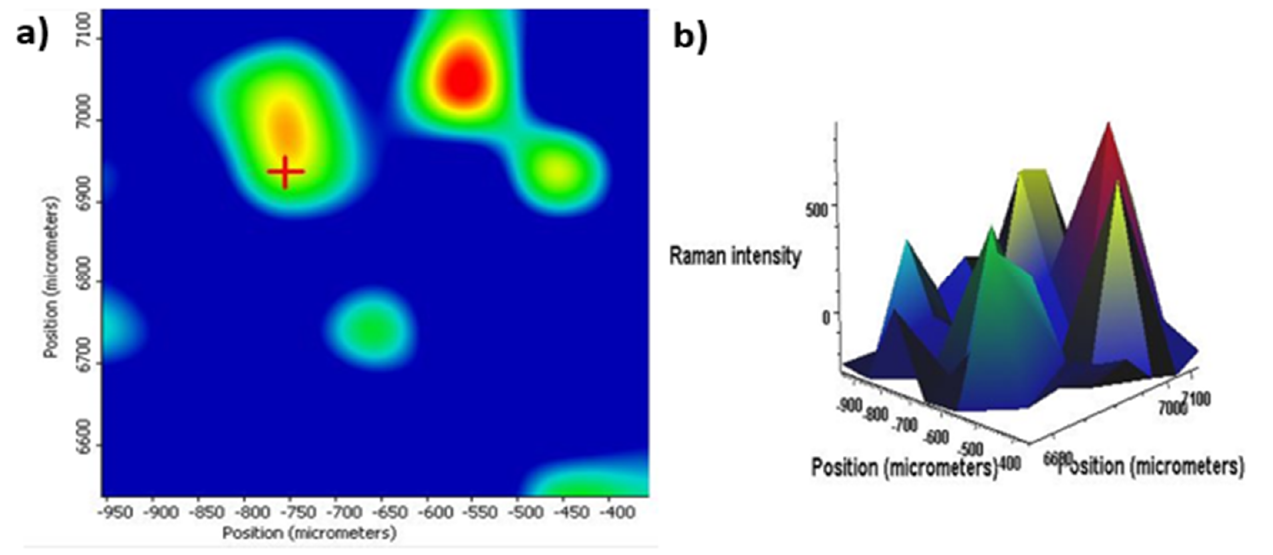
Figure 7. ( a ) Raman mapping of drug crystal surface and ( b ) 3D images of mapped DXM– nf PLGA Composites.